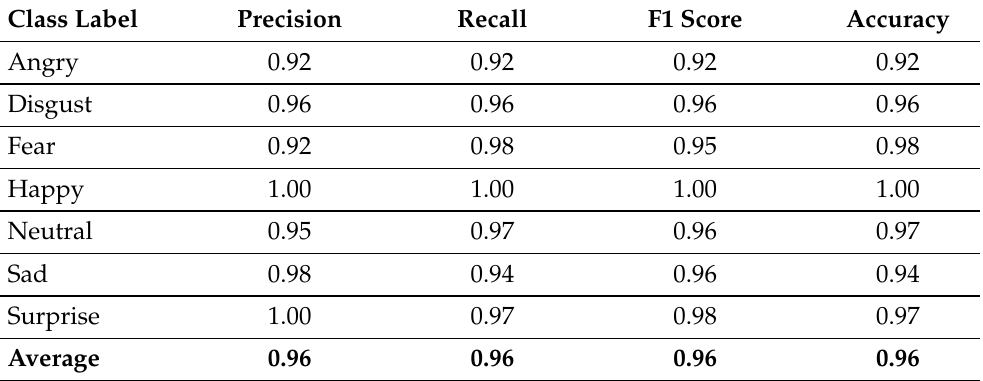
Table 3. Precision, recall, F1 score and accuracy of RIA-DCNN facial expressions recognition.